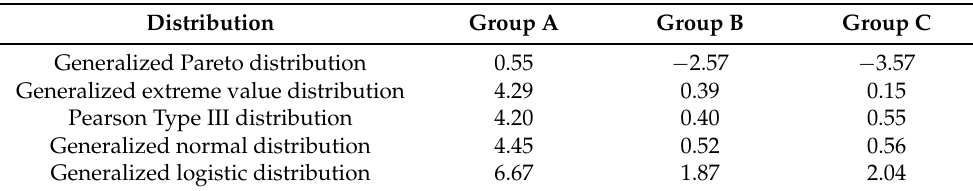
Table 6. Z-statistic values of the homogeneous